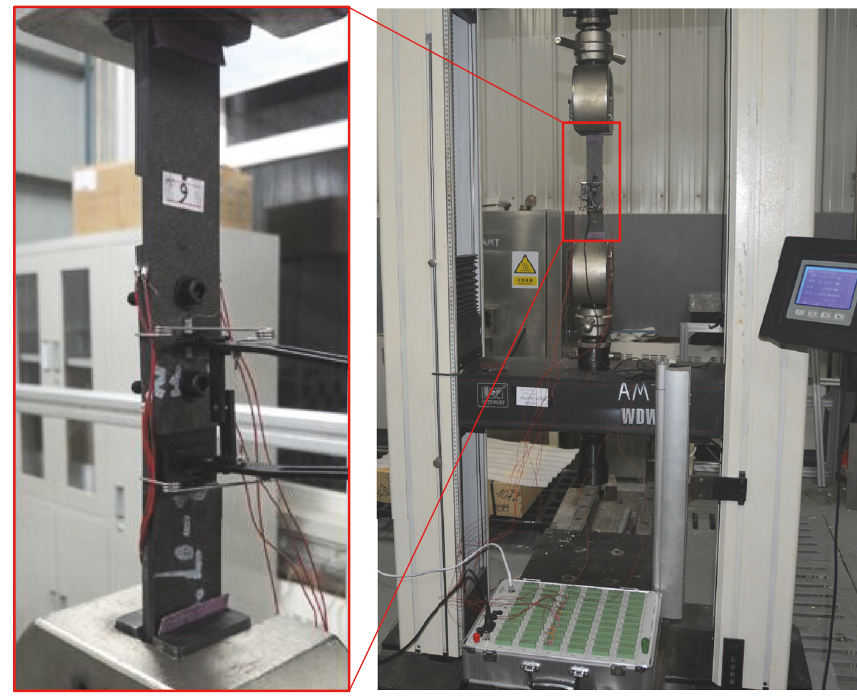
Figure 4: Experimental setup.